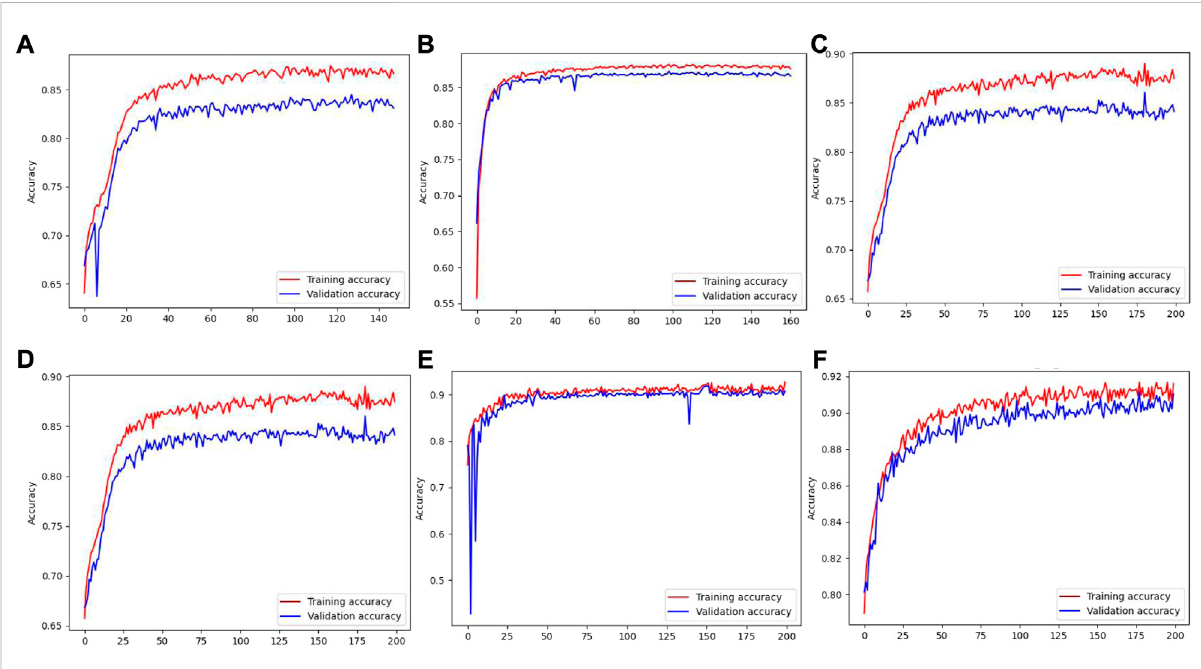
FIGURE 12 (A – C) The training process of CSNet (ResNet-50), CSNet (ResNetB), CSNet (ResNetC) on RGB dataset. (D – F) The training process of CSNet (ResNet-50), CSNet (ResNetB), CSNet (ResNetC) on RGB + NDVI